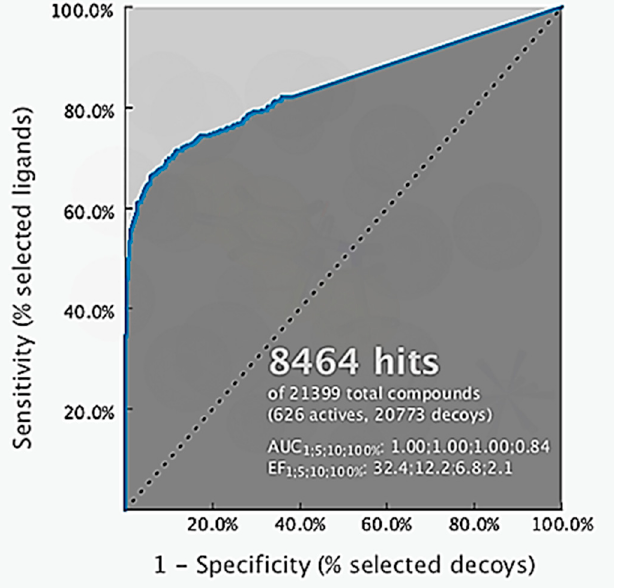
Figure 5. Receiver operating characteristic (ROC) curve validation of the 3D structure-based pharmacophore model using a set of 626 estrogen receptor alpha active and 20,773 decoy molecules. Table 4. LigandScout pharmacophore fit score of ChalcEA derivatives retrieved using the 3D- structure-based pharmacophore derived from 4-hydroxytamoxifen (4-OHT) bound to the estrogen receptor alpha (ER α ). A higher fit score indicates a better geometric alignment of the features of the compound to the 3D-pharmacophore model. The docking score of each compound is provided for comparison.